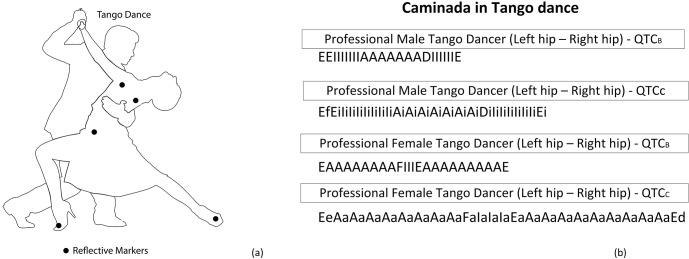
Selected reflective markers (i.e., shoulders, hips, and feet) (a), an example of QTCB and QTCC movement sequences (i.e., ships) of the couple of professional tango dancers (b).